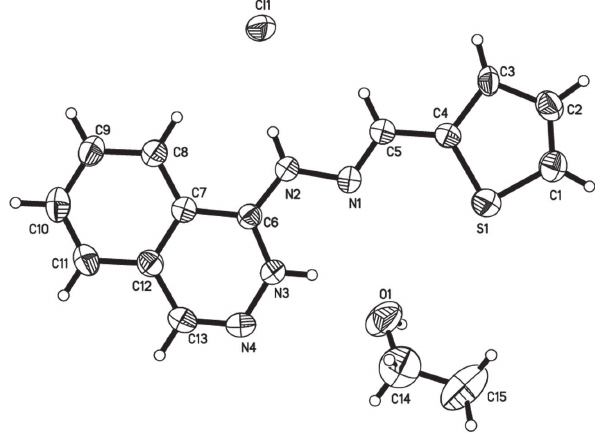
Table 1: Data collection and handling.